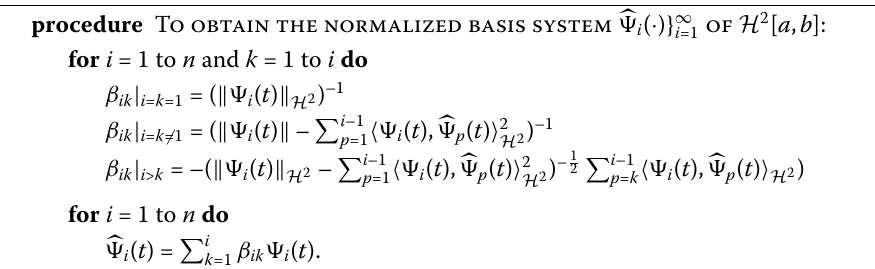
Algorithm 1 Gram–Schmidt normalization